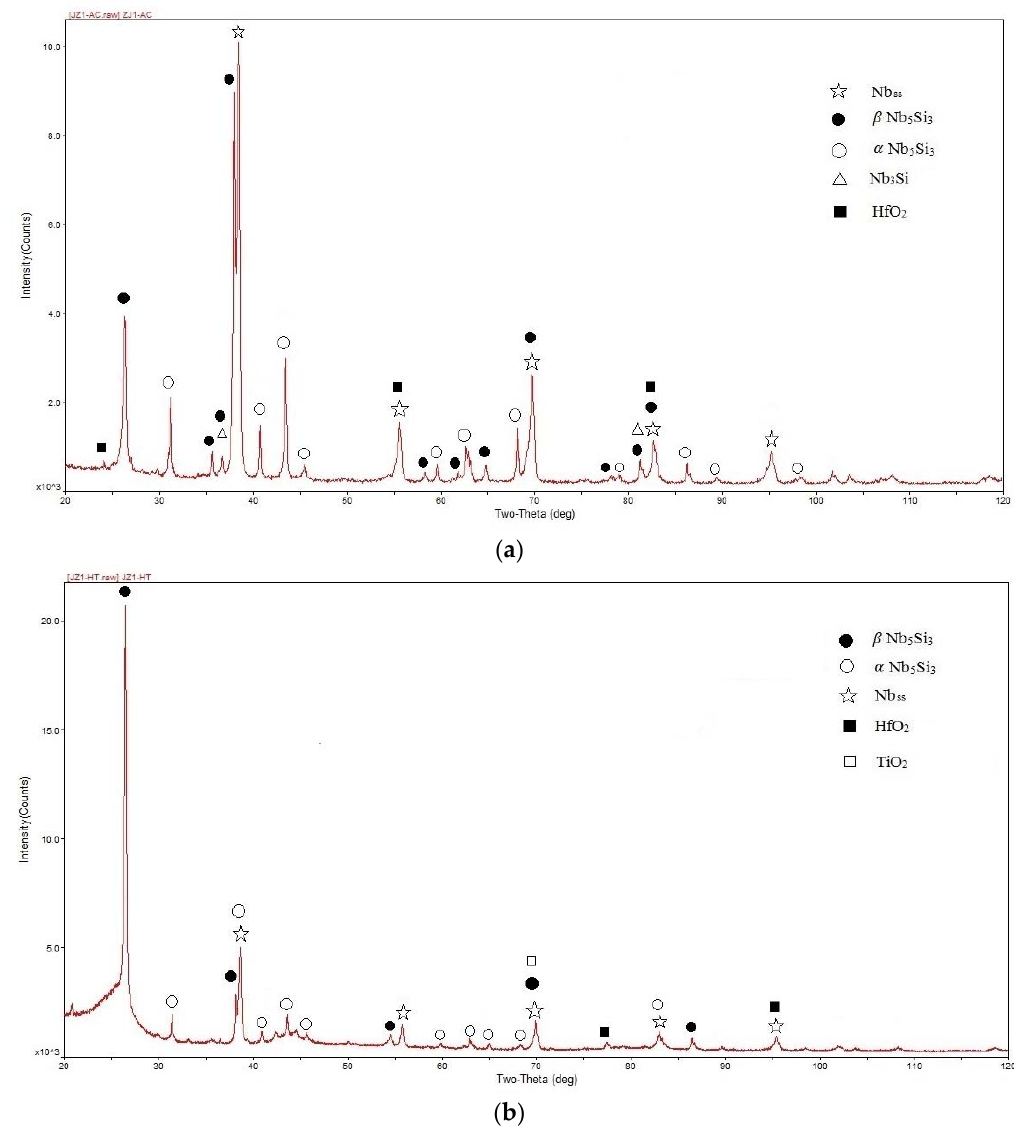
Figure 1. X-ray di ff ractograms of the ( a ) as-cast and ( b ) heat-treated alloy Figure 1. X ‐ ray diffractograms of the ( a ) as ‐ cast and ( b ) heat ‐ treated alloy JZ1.